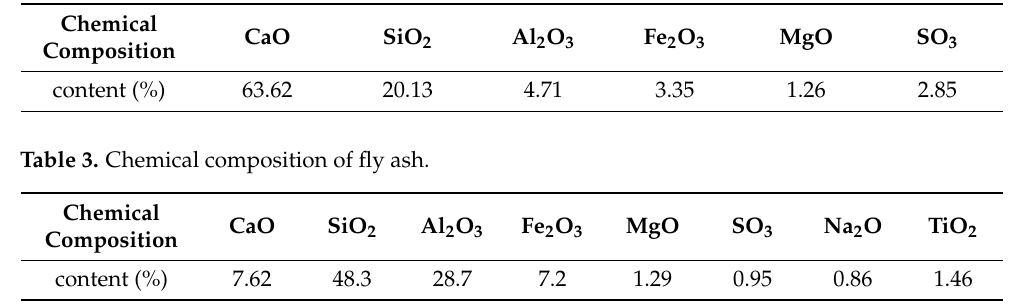
Table 2. Chemical composition of cement.